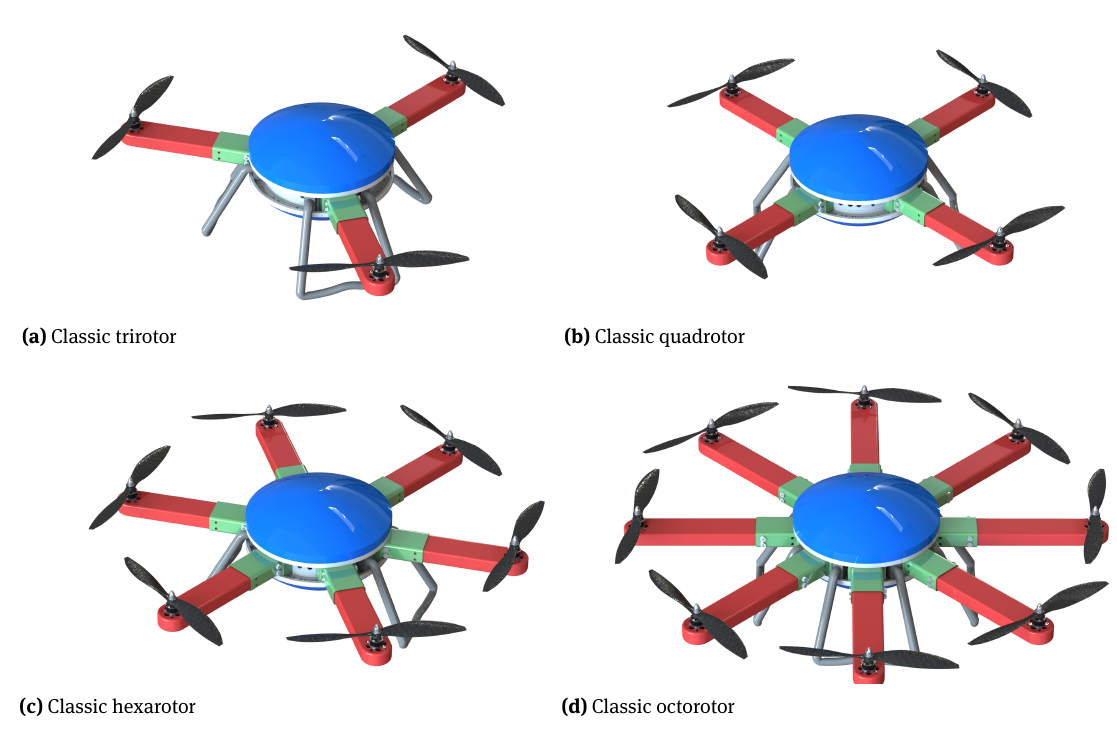
Figure 11: Multirotor configurations with single rotor for each arm.